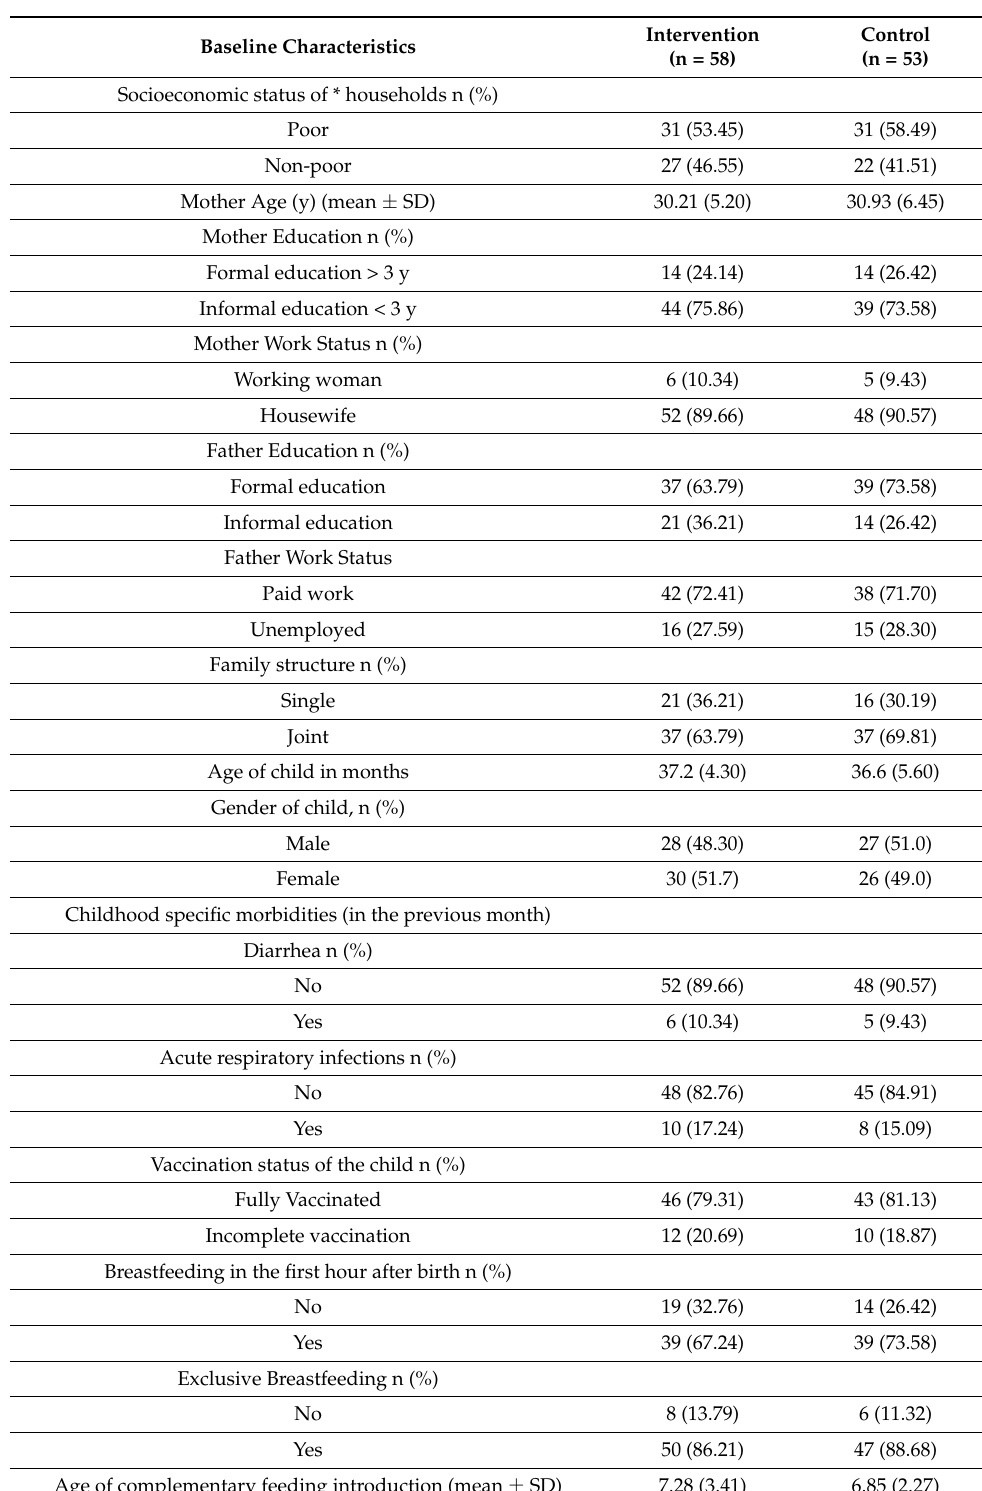
Table 2. Baseline characteristics of households, caregivers, and children by study